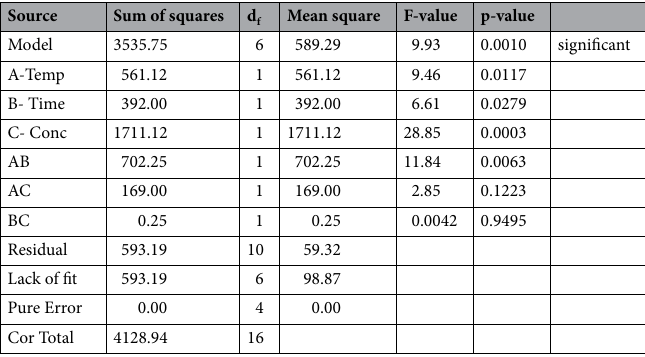
Table 3. Analysis of variance (ANOVA) for the developed model for cellulose nanocrystal yield model